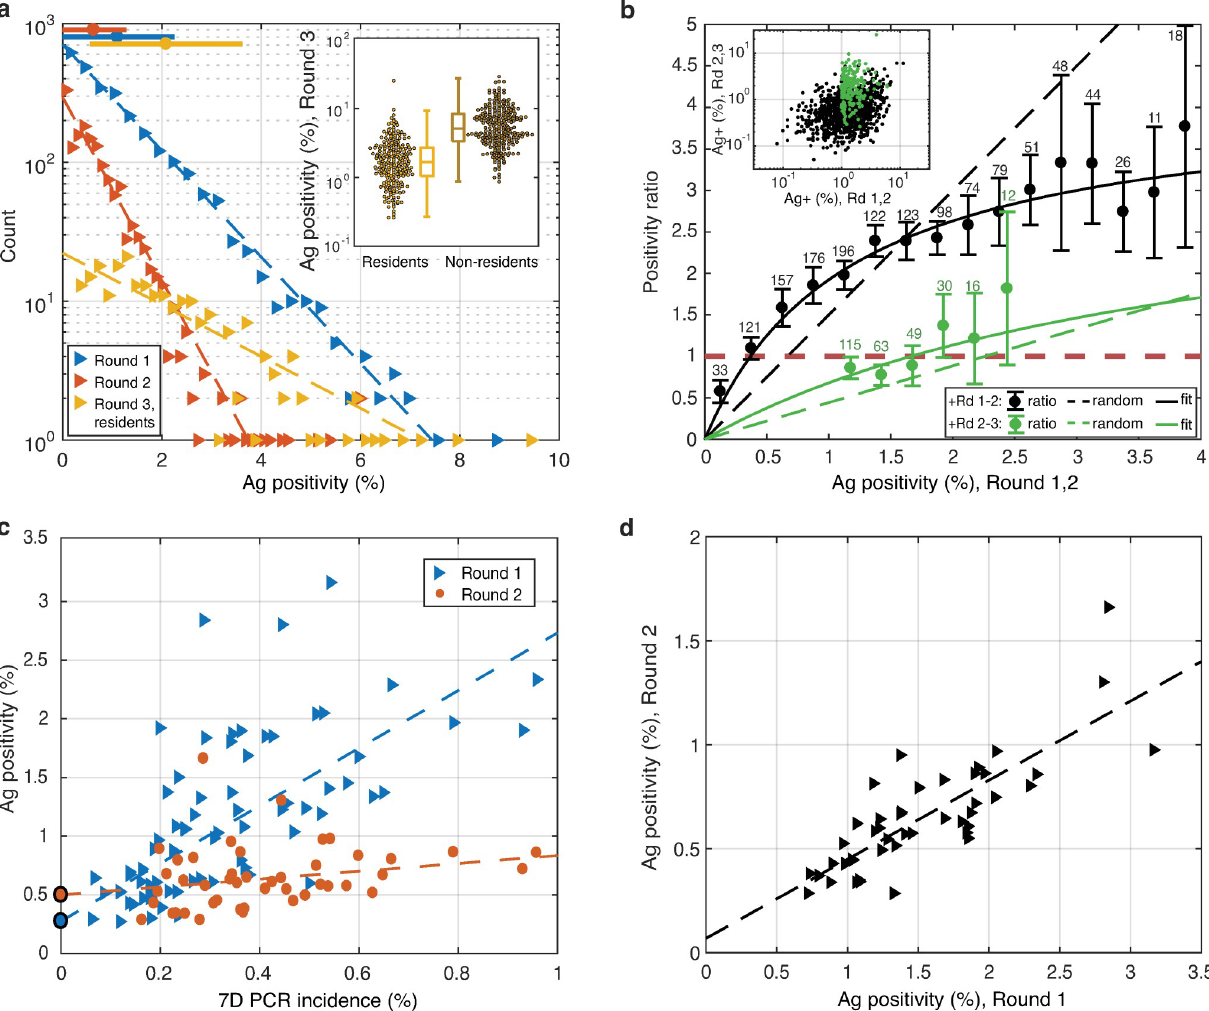
Fig 4. Graphical statistical data analysis. a Histograms of positivity in municipalities in Rounds 1–3. Each triangle represents a number of municipalities within the corresponding positivity bin. Horizontal color bars on the top indicate mean ± std. Dashed lines correspond to exponential fits (S1 Table). Inset shows distributions of positivity for residents (n = 233) vs. non-residents (n = 265) in Round 3 (boxplots included). Zero data is not displayed. b Ratio of positivity in Round 2 vs. Round 1 and Round 3 (residents) vs. Round 2. Municipality based Ag positivity in the subsequent rounds is shown in the inset (only positive data displayed). The vertical bars correspond to 95% confidence intervals obtained by jackknife subsampling of the municipalities within the bin (withholding 50% of the data) with repetition. c Positivity in Rounds 1 and 2 against 7-day PCR incidence prior to Round 1. Dashed lines correspond to linear fits weighted by the population size. d Positivity in Round 2 vs. Round 1 for counties where both testing rounds were administered (n = 45) and the weighted linear fit (S1